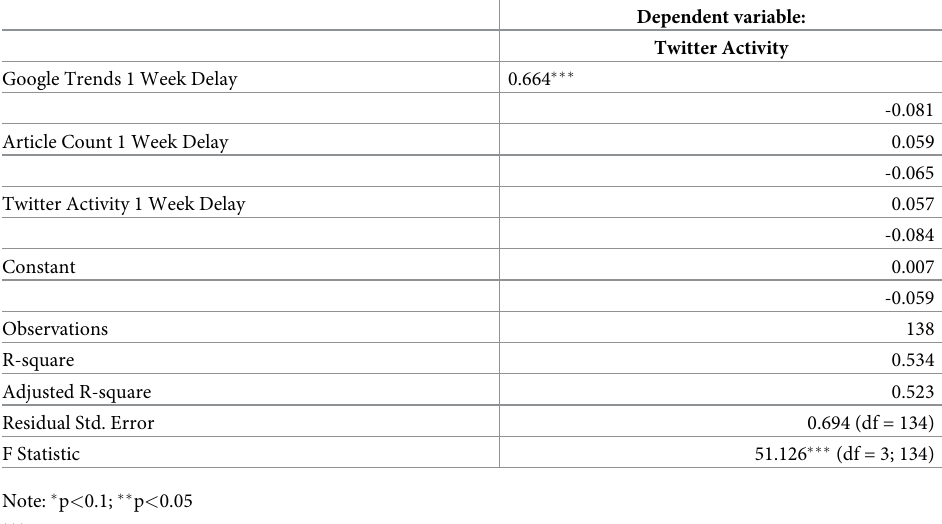
Table 3. Temporal effect of Twitter activity on Google search behavior and newspaper